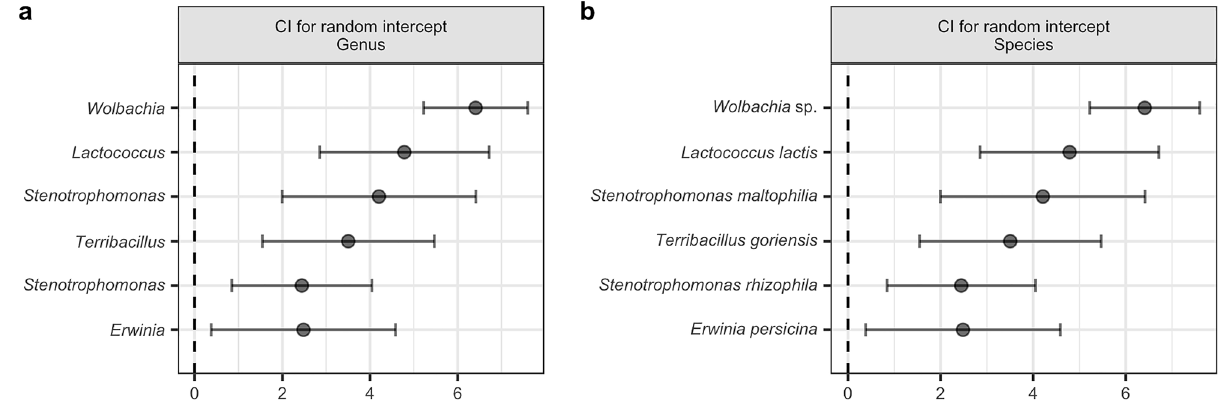
Figure 6. The 99.9% confidence intervals for individual random effects in the hurdle model of the Top Biome consisting of 6 bacterial genera ( a ) and 6 CLB species of bacteria ( b ). The confidence intervals for each taxon are marked. The given level is not significant when the confidence interval crosses zero. On the other hand, if the confidence interval for given taxa is far from zero, it suggests that the microbial abundance of this taxa is significantly different from the overall microbial abundance. Confidence intervals were calculated at 0.001 the significance